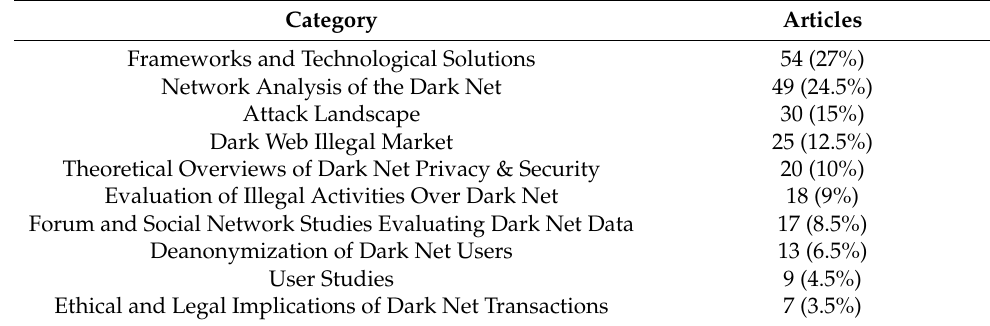
Table 2. Thematic overview of the papers collected and analyzed based on the codebook and themes generated. Note that the total of the percentages is over 100 since the categories are not mutually exclusive.